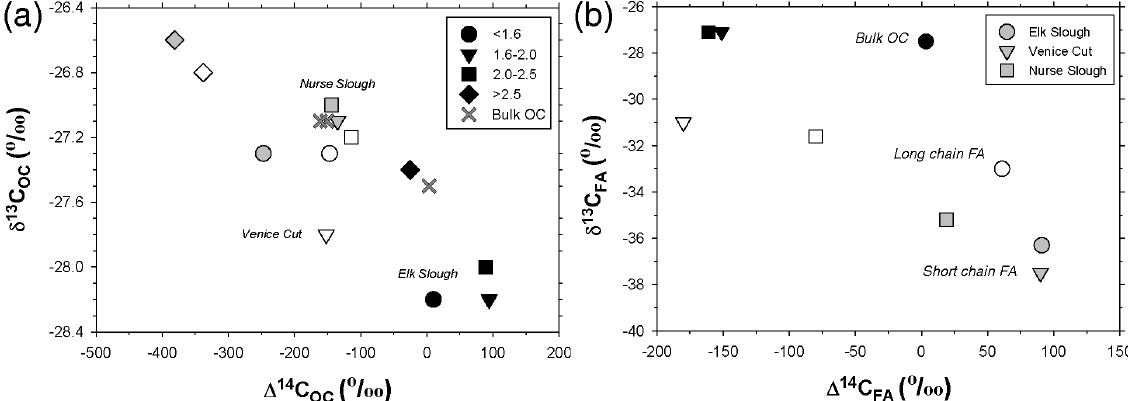
Figure 6. Cross plots of (a) δ 13 C vs. (cid:49) 14 C for OC in Delta bulk sediment and density fractions: black symbols = Elk Slough; white symbols = Venice Cut; gray symbols = Nurse Slough and (b) δ 13 C vs. (cid:49) 14 C for fatty acids in bulk sediments: black symbols = bulk OC; white symbols = long-chain FA; gray symbols = short-chain